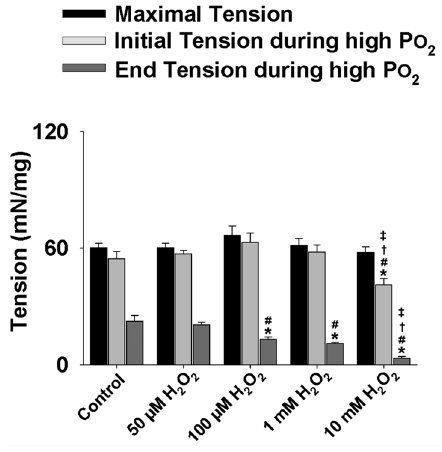
Figure 7. Grouped data showing the effect of varying H 2 O 2 dosage on muscle tension development during high PO 2 . Data showing the muscle tension development (mN/mg) during the H 2 O 2 dosage treatments in mouse diaphragm strips [0 m M (control), 50 m M, 100 m M, 1 mM and 10 mM] in high PO 2 (550 Torr). *Significantly different from control ( P , 0.05). # Significantly different from 50 m M H 2 O 2 ( P , 0.05). { Significantly different from 100 m M H 2 O 2 ( P , 0.05). ` Significantly different from 1 mM H 2 O 2 ( P ,